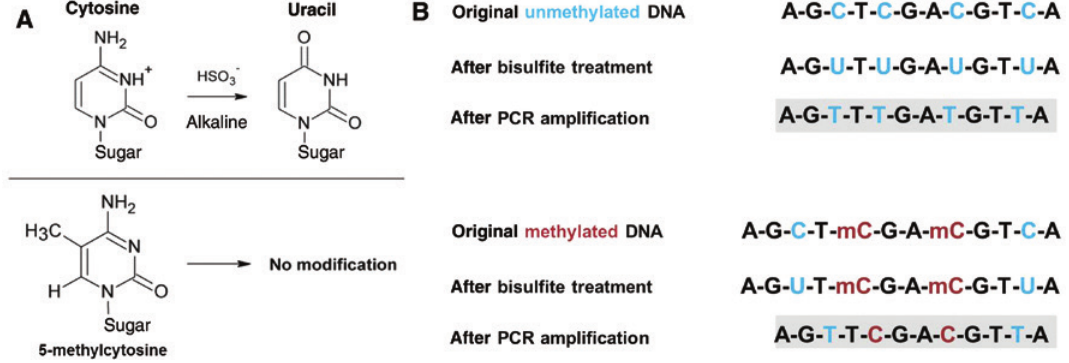
Figure 2: (A) Sodium bisulfite converts cytosine into uracil (in series of steps), but methylcytosine is not converted. (B) An example of DNA sequences that become modified after bisulfite treatment and subsequent PCR amplification, depending on whether they were originally unmethylated (top) or methylated (bottom).